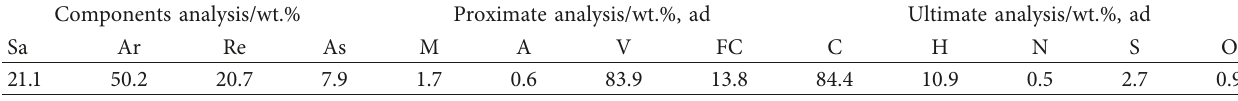
Table 1: Components, proximate, and ultimate analyses of the sample. Components analysis/wt.%